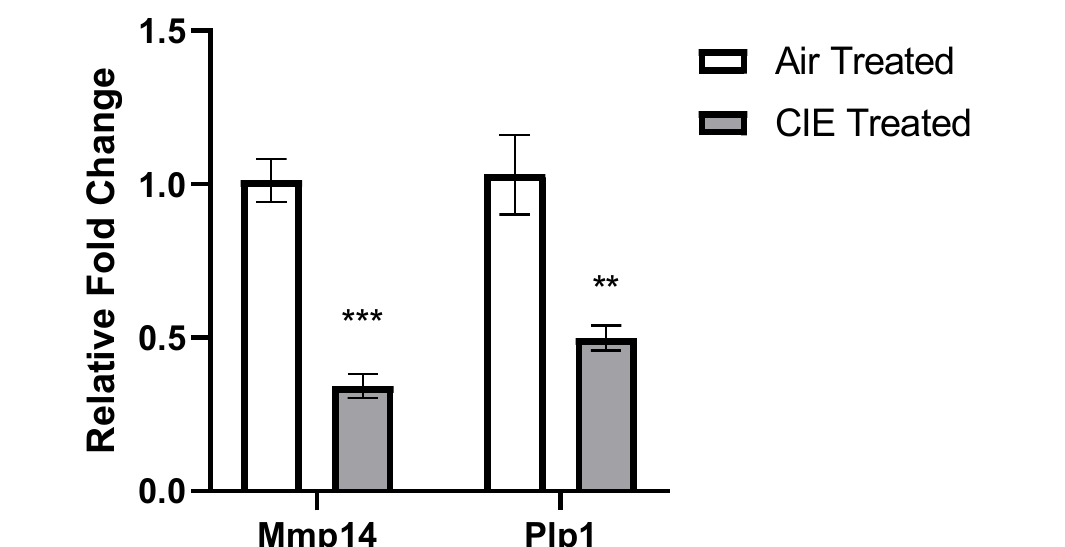
Figure 1. ( A ) Volcano plot showing differentially expressed genes (DEGs) (in color). Highlighted are the top statistically significant DEGs, up-regulated in the CIE group (on the right) and down-regulated in the CIE group (on the left). ( B ) Heat map of DEGs at 5% false discovery rate. Ethanol CIE group (E) and control air group (C). Representative cell and tissue type-specific genes are shown on the right.